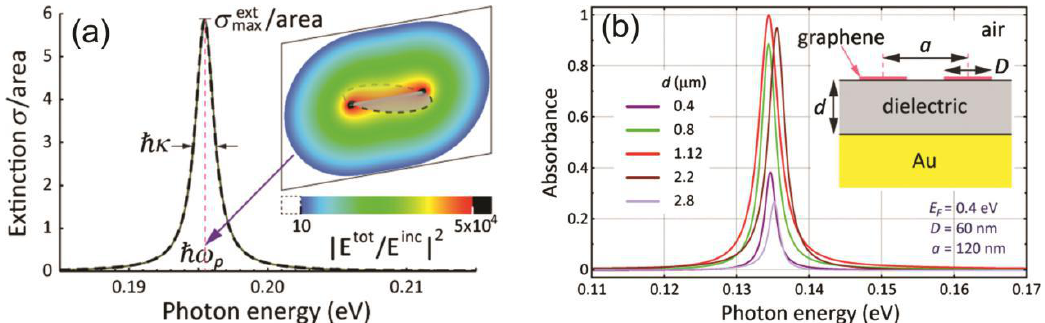
Figure 3 Figure 3. ( a ) Characteristic extinction cross section of a nanodisk (60 nm in diameter and Fermi energy E F = 0.4 eV), dominated by a pronounced dipolar plasmon and strong near-field enhancement. Solid curve: Full electrodynamic calculation. Dashed curve: Fit to a Lorentzian polarizability. Inset: Near-field intensity normalized to incident intensity for plane-wave illumination with polarization parallel to the disk. ( b ) Normal-incidence absorbance by graphene disk arrays supported on a dielectric-coated gold surface (see the inset) for various values of the dielectric film thickness. Reproduced from reference [87], with permission from American Physical Society,